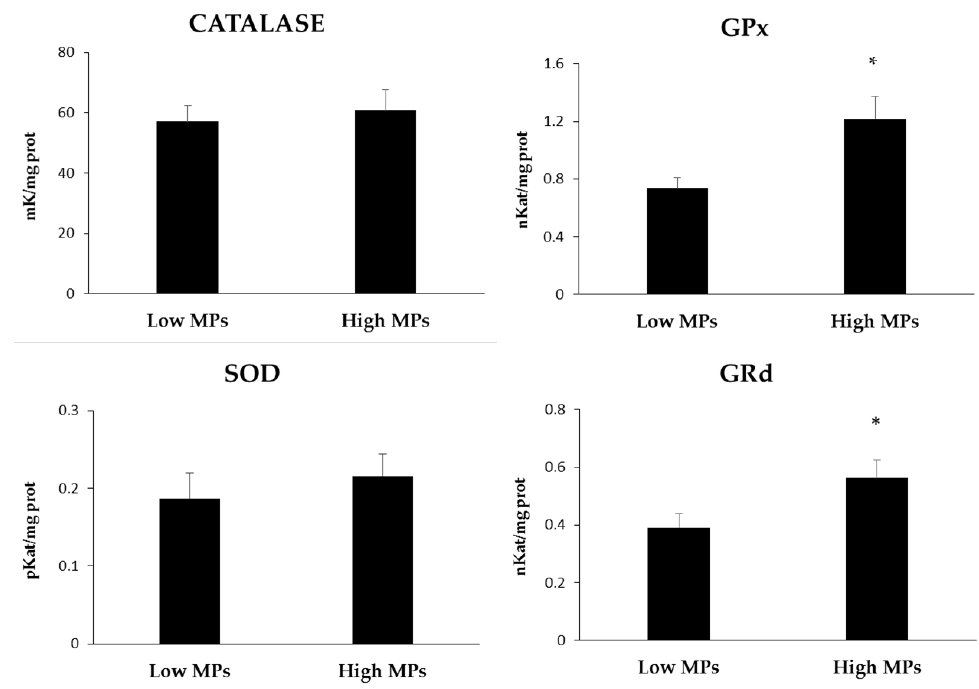
Figure 4. Oxidative stress biomarkers determined in the liver tissue homogenates of Xyrichtys novacula sampled in Eivissa (Balearic Islands, Spain). Superoxide dismutase (SOD); glutathione peroxidase (GPx); glutathione reductase (GRd). * indicates significant differences ( p < 0.05) between groups.